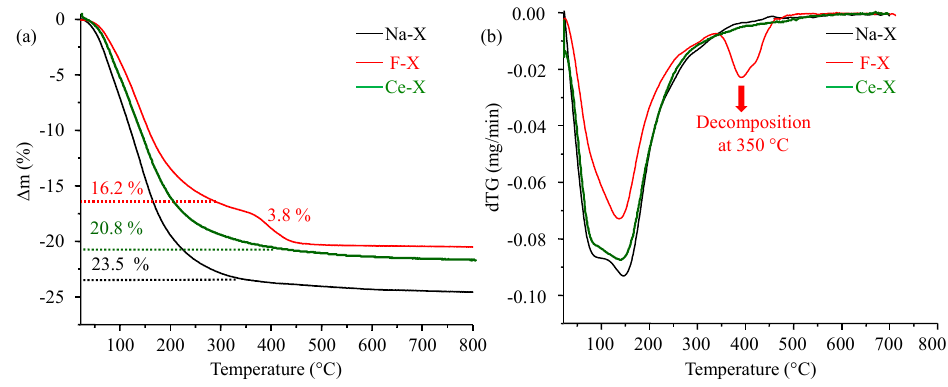
Figure 2. ( a ) Thermogravimetric (TG) and ( b ) differential thermogravimetric (DTG) curves of as- synthesized Na-X, fluorinated F-X, and cerium ion exchanged Ce-X zeolites.